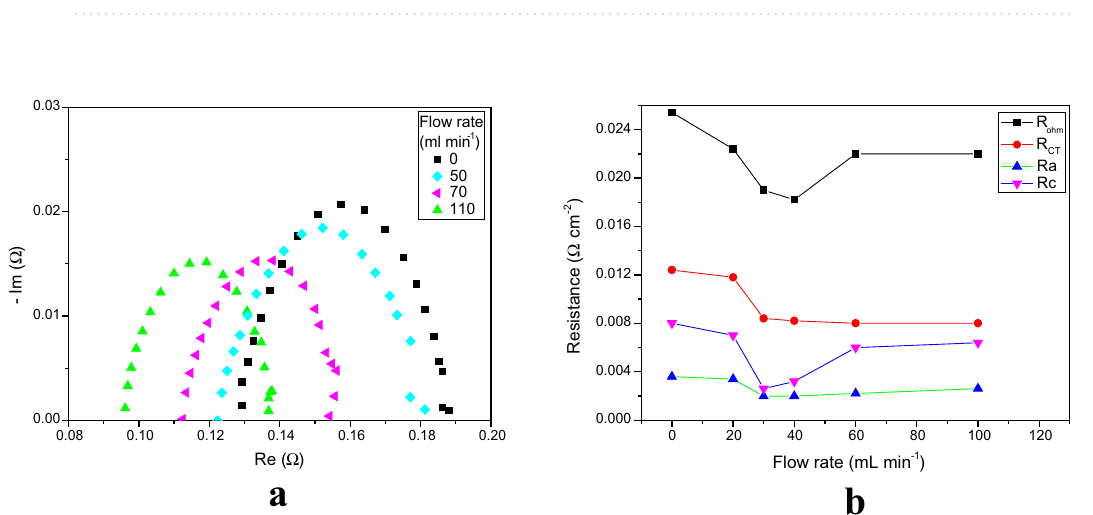
Figure 6. (a) Nyquist plots of EIS measurements (from 100 kHz to 1 MHz) from the function of liquid electrolyte flow rate at 1.9 V. ( b) Variation in the relevant electrochemical resistances as a function of flow rate at 1.9